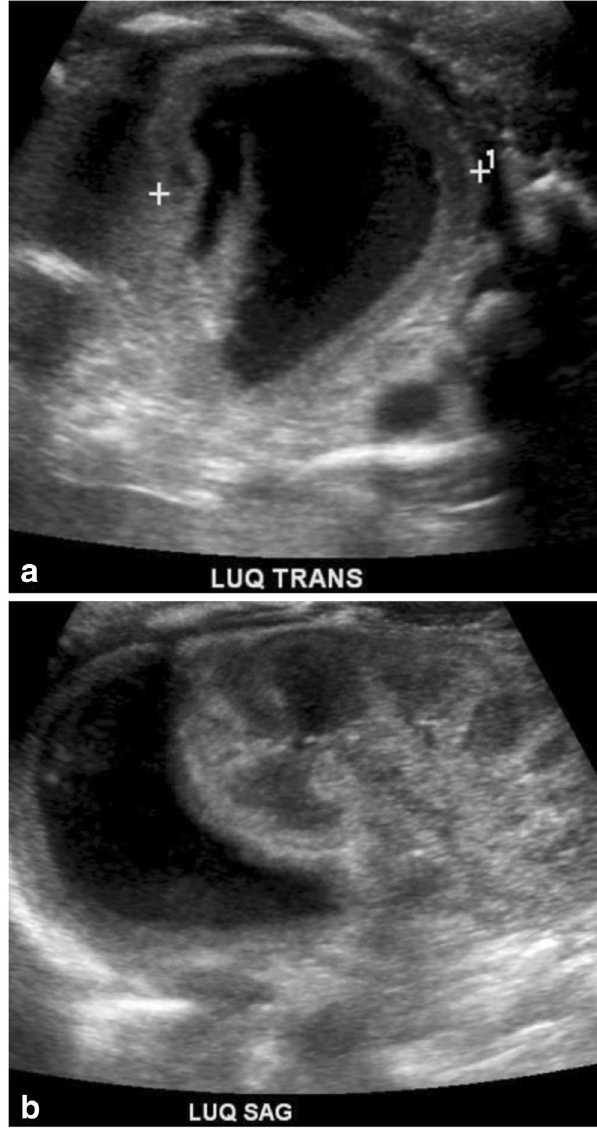
Fig. 20 Visceral Injury Ultrasound of the left upper quadrant performed in a 3-day-old revealed a crescentic, near anechoic collection in the loca- tion of the left adrenal. Baby had a history of difficult birth characterized by prolonged 2nd stage of labor. Hematoma was followed by serial ultra- sound and resolved at 13 weeks of